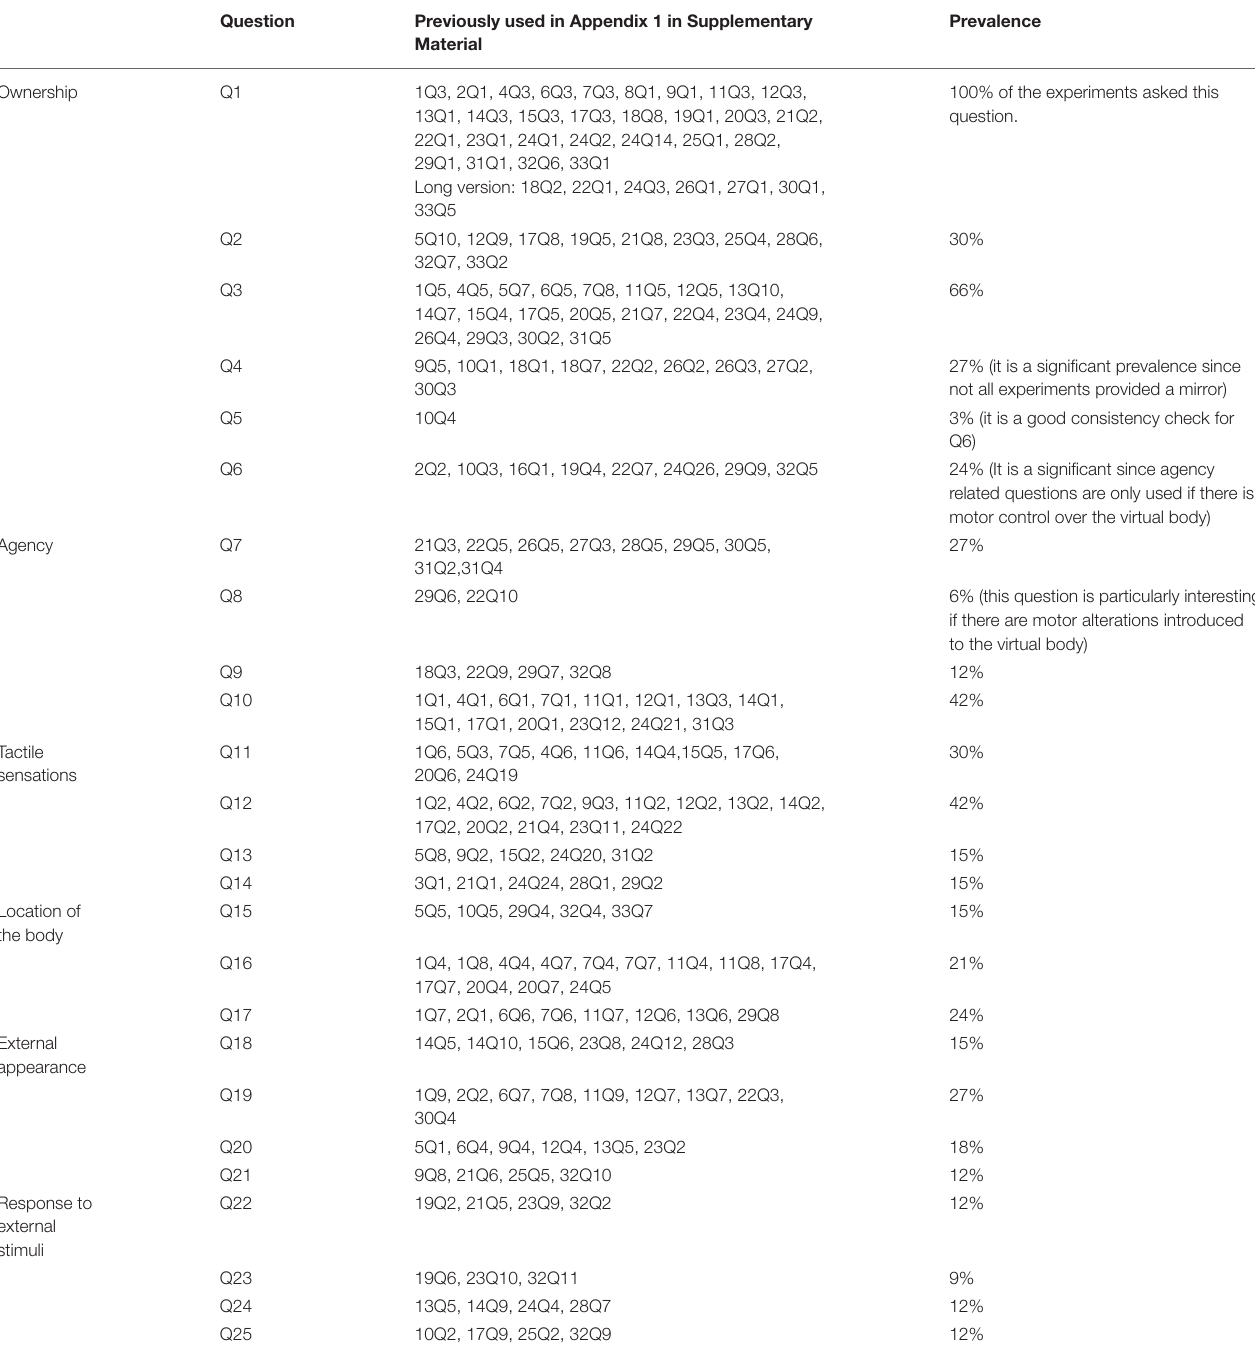
TABLE 1 | Prevalence of the proposed questions in the literature (represented by Appendix 1 in Supplementary Material). Question Previously used in Appendix 1 in Supplementary Material